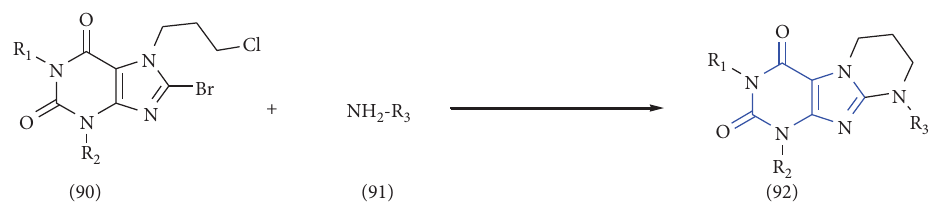
Scheme 14: Synthesis of tetrahydropyrimido [2,1-f] purinediones using the convergent approach.